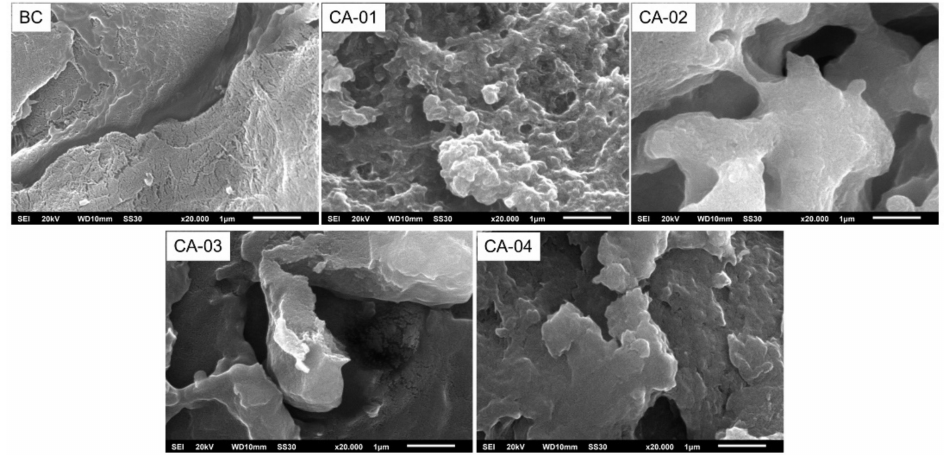
Figure 6. SEM micrographs of BC and